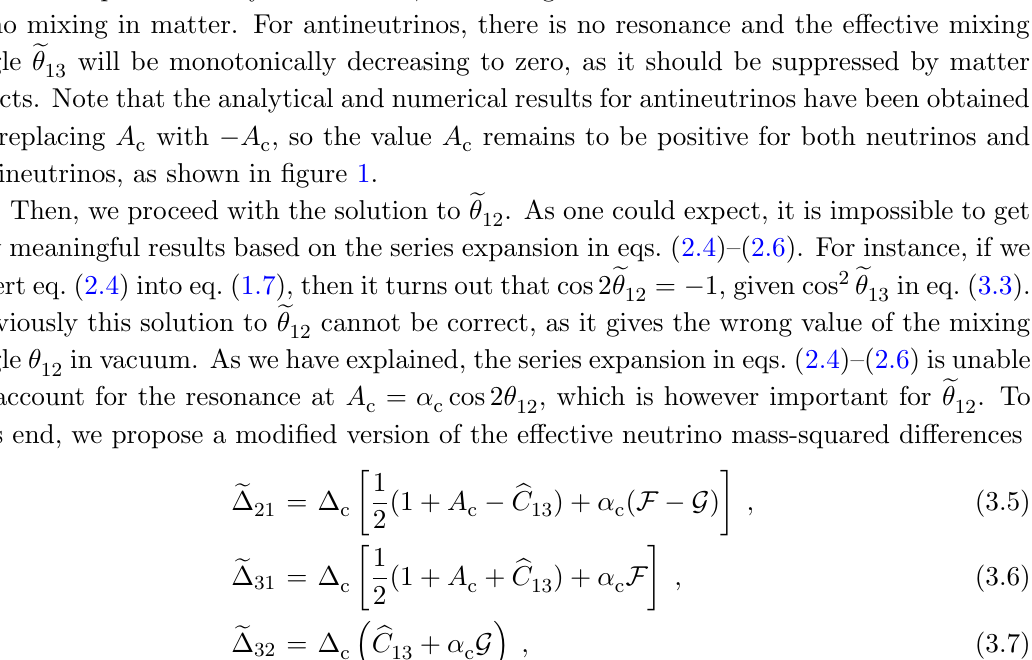
Figure 1 . Left panel : analytical and numerical solutions to e (cid:18) ordering, where the best-(cid:12)t values of neutrino mixing parameters from ref. [25] have been used in the numerical calculations. The solid curves stand for the analytical solutions, while the dashed ones for the numerical solutions. In addition, the red and orange curves are for neutrinos while the blue and green ones for antineutrinos. Right panel : the di(cid:11)erence (cid:1) e (cid:18) between the analytical and numerical results has been plotted as the red curve for neutrinos while the blue curve for